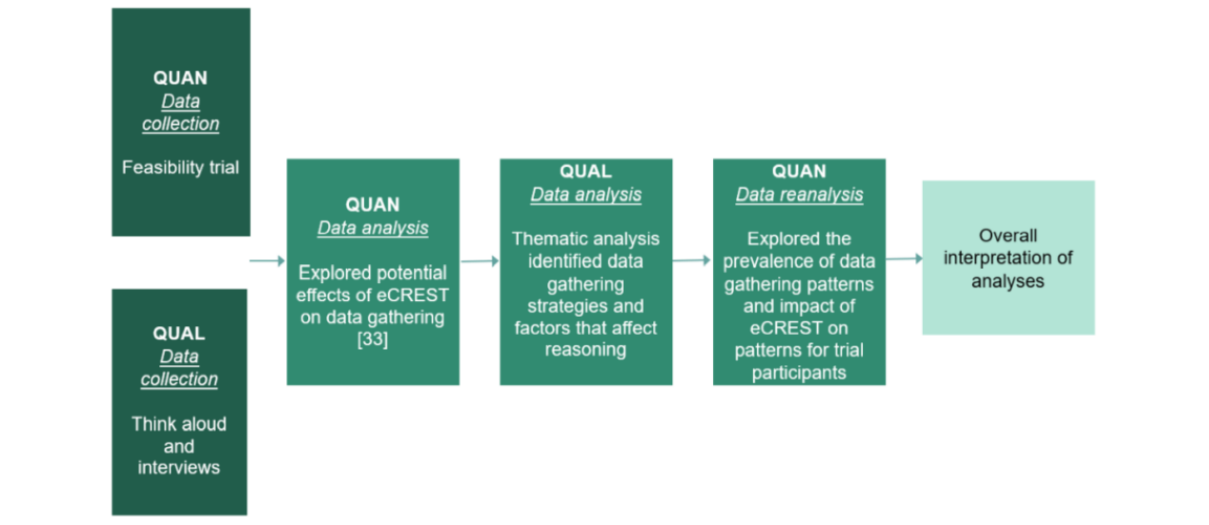
Figure 1. Process of the mixed methods approach. QUAL: qualitative; QUAN: